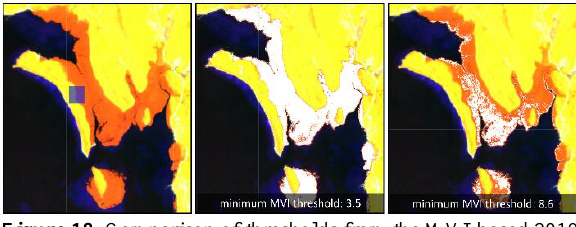
Figure 18 . Comparison of thresholds from the MVI-based 2019 Mangrove Extent Map of the Philippines and the automated Otsu method: FCC and the subset for Otsu analysis in the blue geometry (left), for the case MVI ≥ 3.5 from the 2019 map (middle) and for the case MVI ≥ 8.6 as determined using the Otsu method (right). The white pixels are those identified to be mangroves based on the